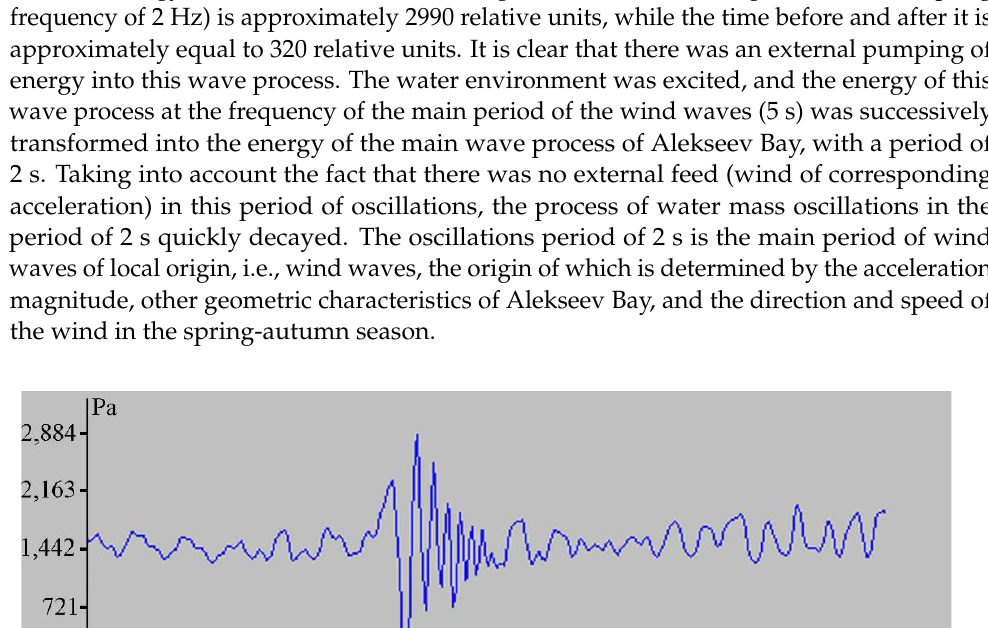
27 September 2020, installed on the seabed at a depth of 4 m in Alekseev Bay, Popov Island with the registration of a nonlinear hydrophysical disturbance of the rogue wave type against the back- ground of seiches of local origin.